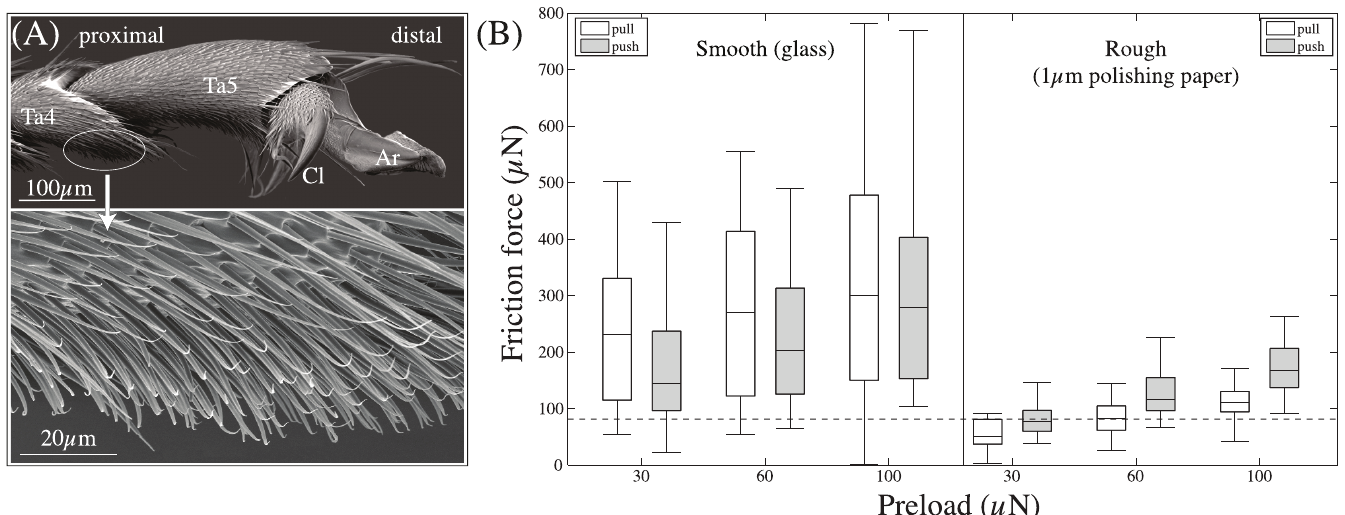
Fig 6. Morphology of tarsal hairs in O. smaragdina ants and generated friction forces. (A) Morphology of hairs on the underside of the tarsus. Ta4 & Ta5: 4 th & 5 th tarsomere, respectively; Cl: Claws; Ar: Arolium; (B) Friction forces of tarsal hairs on a smooth and a rough substrate. Slides were performed in the pulling and pushing direction with a constant normal load of 30, 60 and 100 μ N. The dashed line indicates the ants ’ body weight (82 μ